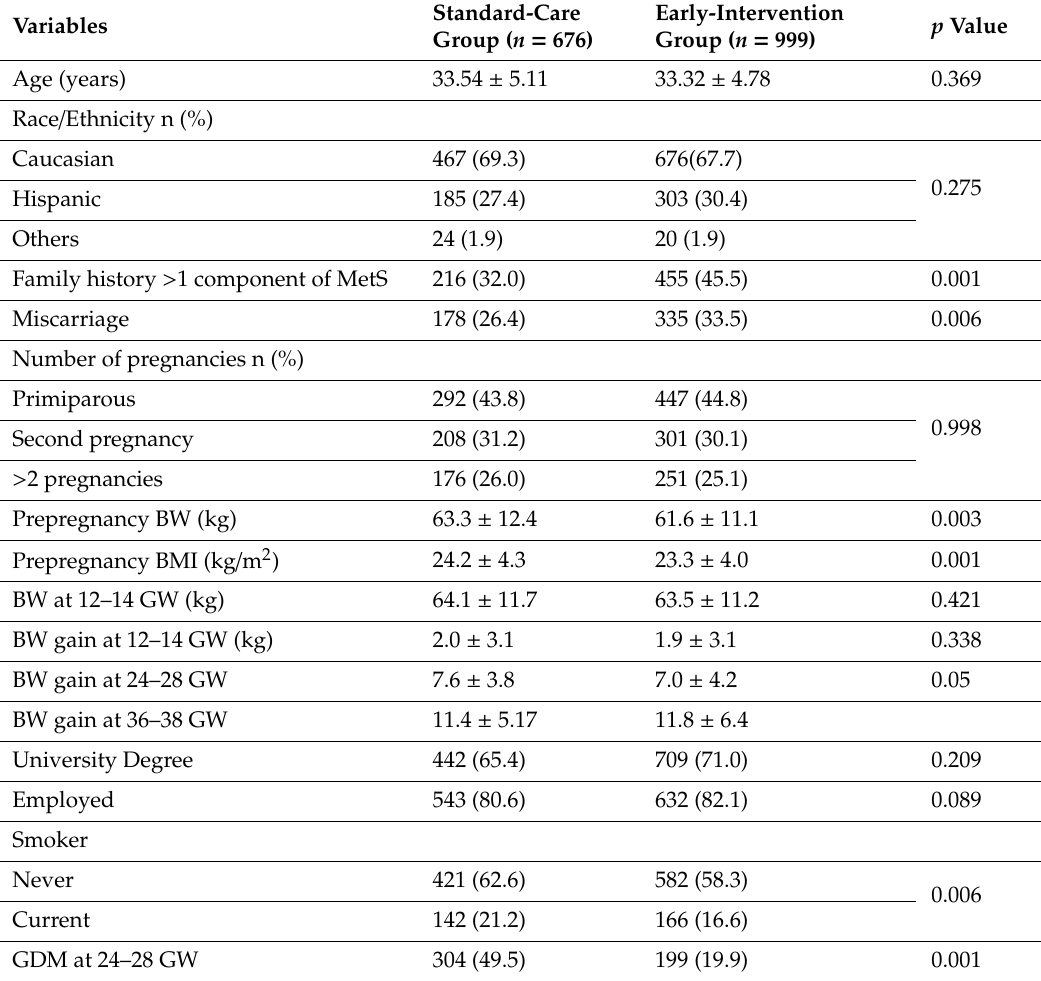
Table 1. Demographic and clinical characteristics of the sample classified as standard care and early-intervention